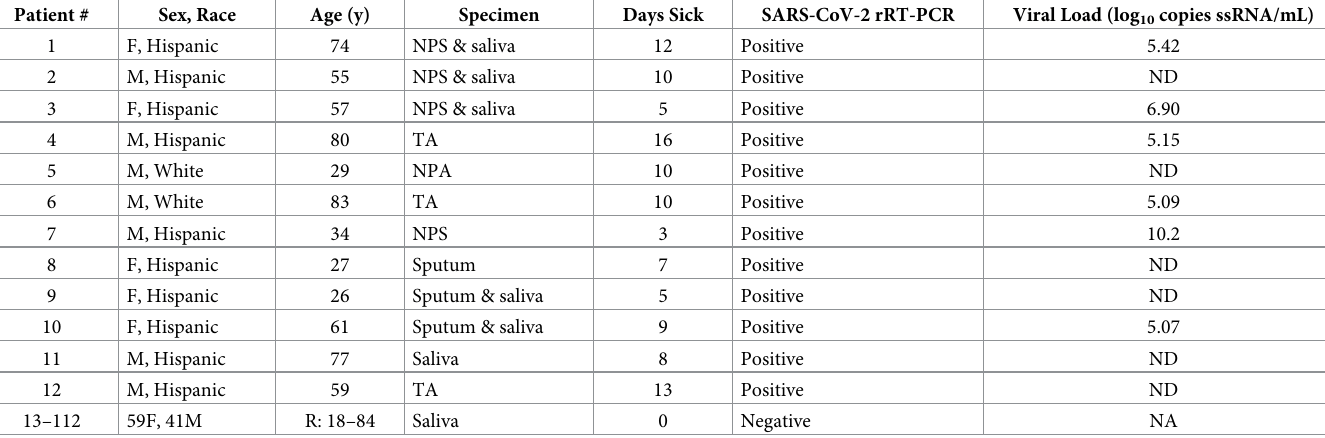
Table 1. Human subjects who provided specimens for in vitro training and experimentation (phases 1 and